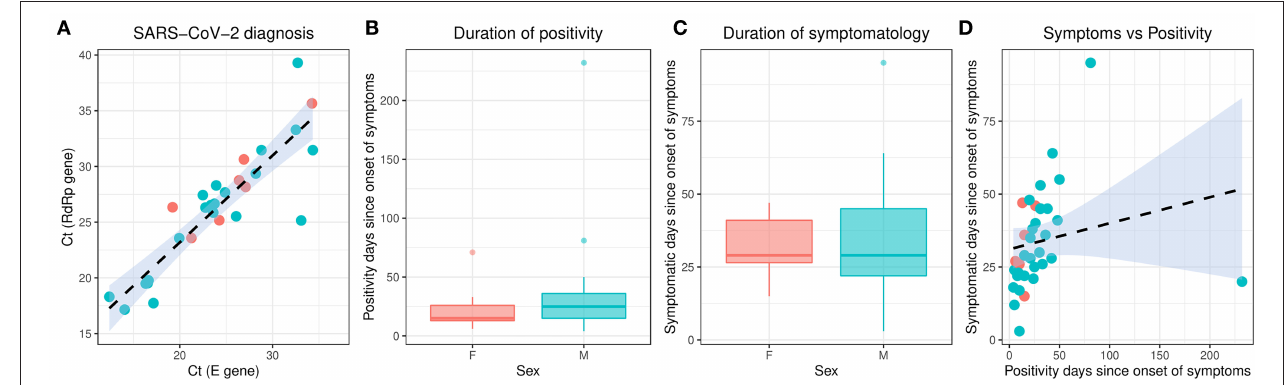
FIGURE 1 | Molecular characterization of the studied individuals during the first SARS-CoV-2 pandemic phase in Brazil. The different colors represent the female and male individuals. (A) Correlation of the SARS-CoV-2 detection to Envelope and RdRp genes. (B) Duration of positivity on Envelope molecular assay after the symptom onset. Boxplots represent the 75th percentile, median, 25th percentile, and the whiskers extend to the highest and lowest value in the 1.5 × interquartile range. (C) Duration of symptomatology since the onset of symptoms. Boxplots represent the 75th percentile, median, 25th percentile, and the whiskers extend to the highest and lowest value in the 1.5 × interquartile range. (D) Correlation of the duration of symptoms to the duration of positivity after the onset of symptoms. SARS-CoV-2, severe acute respiratory syndrome coronavirus